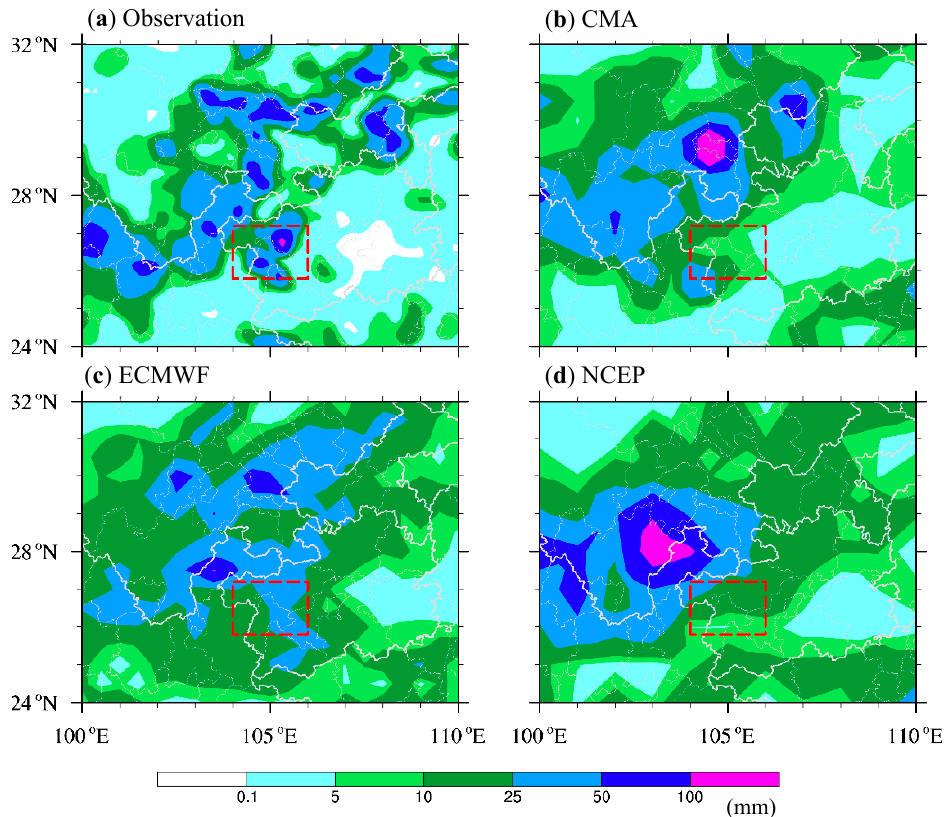
Figure A1. ( a ) Observational data, ( b ) the control forecast of the CMA (China Meteorological Administration), ( c ) the control forecast of ECMWF (European Center for Medium-Range Weather Forecasts), and ( d ) the control forecast of NCEP (National Centers for Environmental Prediction) for the 24-h accumulated precipitation on 22 July 2019 (unit: mm). The lead time for the three models are 00:00 UTC on 22 July 2019. The above global models have horizontal resolution of 0.5° × 0.5°. The dashed-line red box outlines the area of interest in our study.